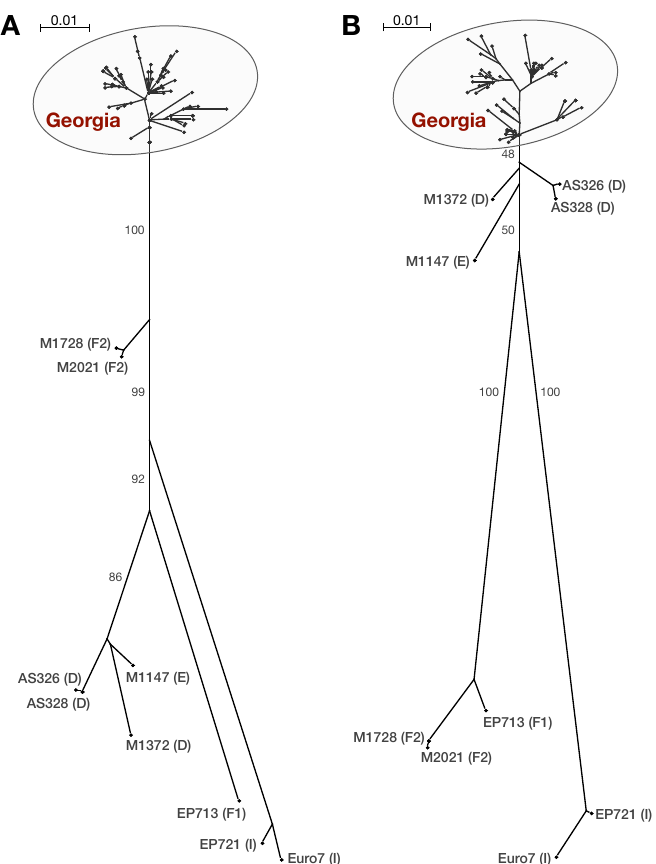
Figure 3. Individual gene trees of CHV-1 strains from Georgia and reference strains generated under maximum likelihood criterion (PhyML) using the GTR + gamma substitution model. ( A ) Gene tree of 71 ORFA sequences of CHV-1 (695 nt, 211 (30.4%) parsimony informative sites). ( B ) Gene tree of 70 ORFB sequences of CHV-1 (715 nt, 210 (29.4%) parsimony informative sites). Trees are unrooted. The scale bar represents the number of substitutions per site for a unit branch length. Numbers beside branches represent bootstraps support (%) of 1.000 bootstrap replicates. For the sake of simplicity, values of terminal branches are not shown and all CHV-1 strains from Georgia are indicated by a grey circle. Samples ID of the CHV-1 reference subtypes (D, E, F, F2 and I) are written beside nodes with the subtype denomination in